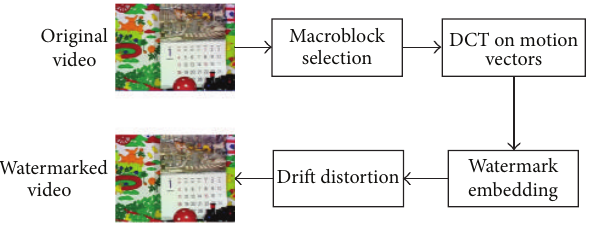
Figure 4: Framework of our